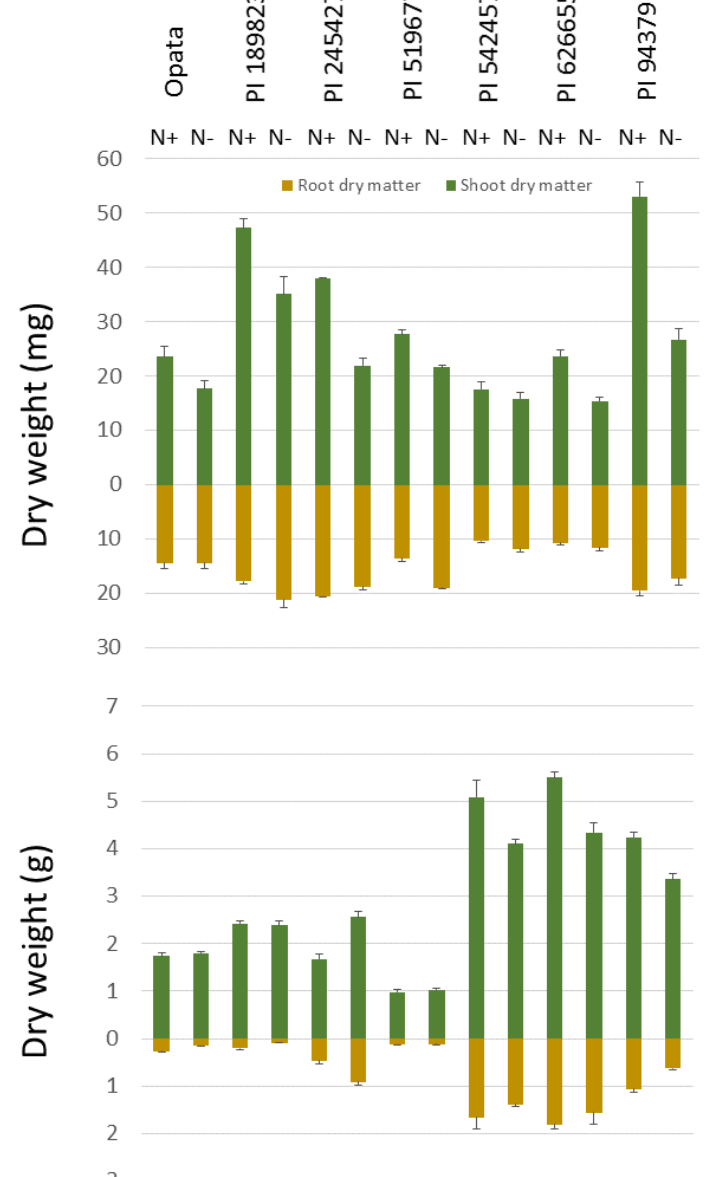
Figure 3. Shoot and root dry matter presented for the seedling ( top ) and maturity ( bottom ) assays. Error bars represent the standard errors of the means for each line in each treatment. The root dry weight is presented below the horizontal axis to demonstrate that the mass recorded is from belowground.